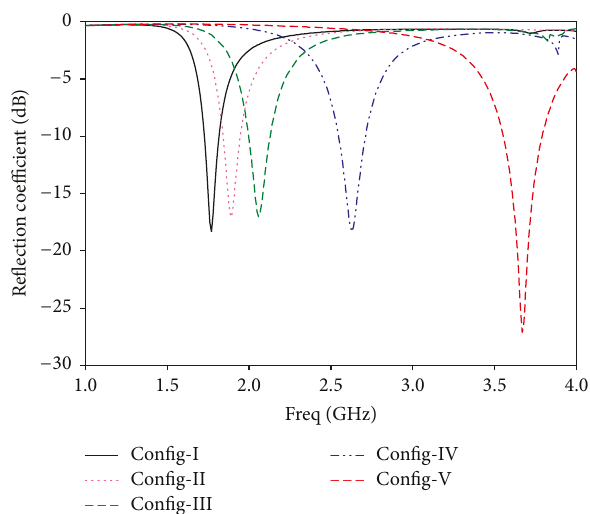
Figure 14: Simulated 𝑆 -parameters corresponding to five different configurations.